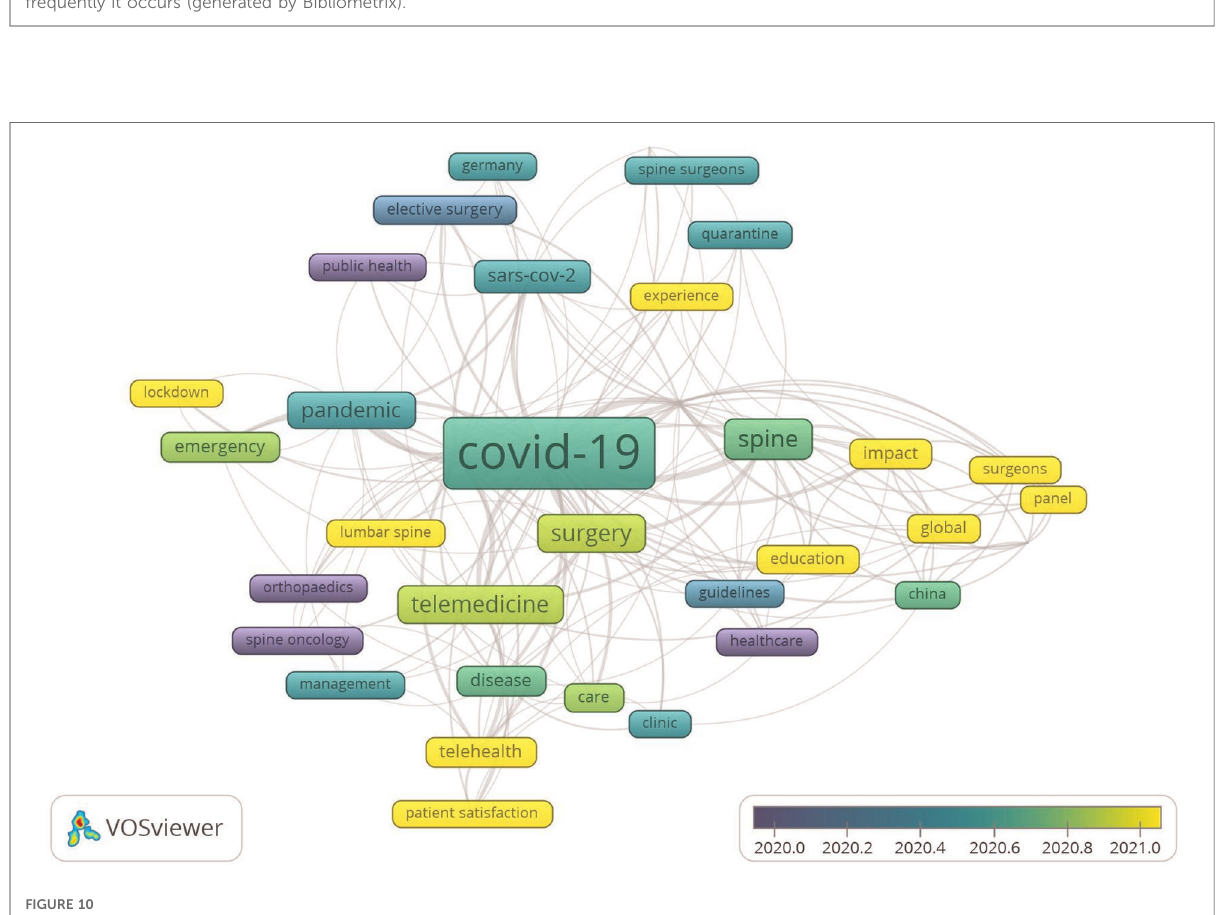
FIGURE 10 Network diagram of keyword hotspot